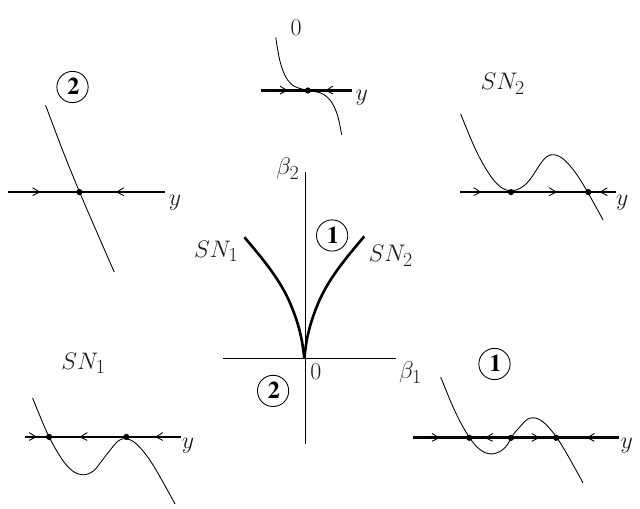
3 . 1 + (cid:12) 2 y (cid:0) y